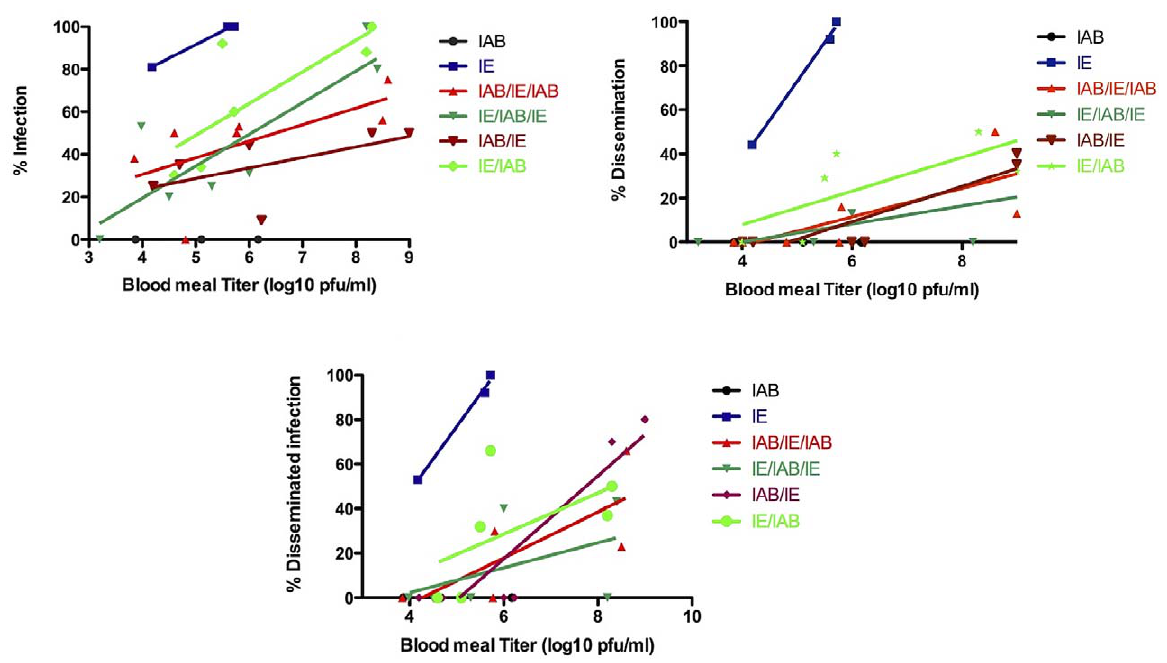
Figure 4. Oral exposure dose response of each virus examined during infection and dissemination in C.taeniopus . Regression lines were generated for each virus for the purpose of visualizing the results. Graph A represents the percentage of infection at a given dose. The goodness of fit R 2 values were 0.995, 0.421, 0.725, 0.340, and 0.617 for IE, IAB/IE/IAB, IE/IAB/IE, IAB/IE, and IE/IAB, respectively. Graph B represents the percentage of dissemination at a given dose, which yielded R 2 values of 0.996, 0.535, 0.465, 0.820, and 0.500 for IE, IAB/IE/IAB, IE/IAB/IE, IAB/IE, and IE/ IAB, respectively. Graph C represents the percentage of disseminated infection, which resulted in R 2 values of 0.992, 0.606, 0.2397, 0.838, and 0.305 for IE, IAB/IE/IAB, IE/IAB/IE, IAB/IE, and IE/IAB, respectively.